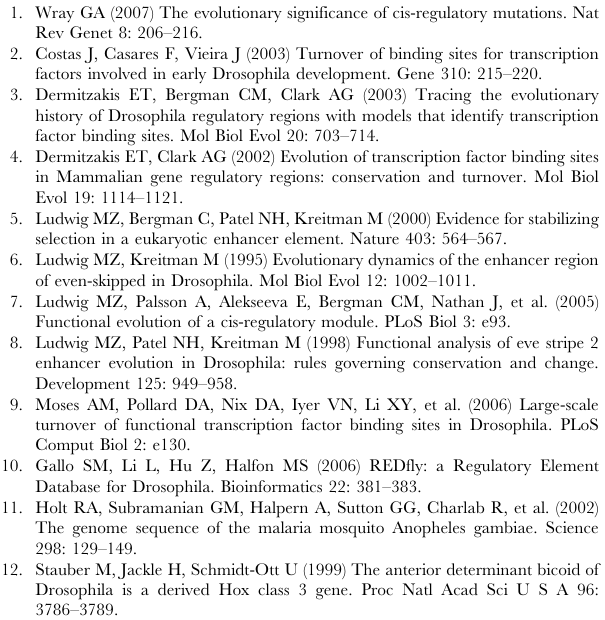
Table S2 even-skipped containing scaffolds or fused scaffolds used Table S3 Pairwise sequence and binding site comparisons. Table S4 Predicted and tested sepsid enhancers. Table S5 Analyzed Drosophila